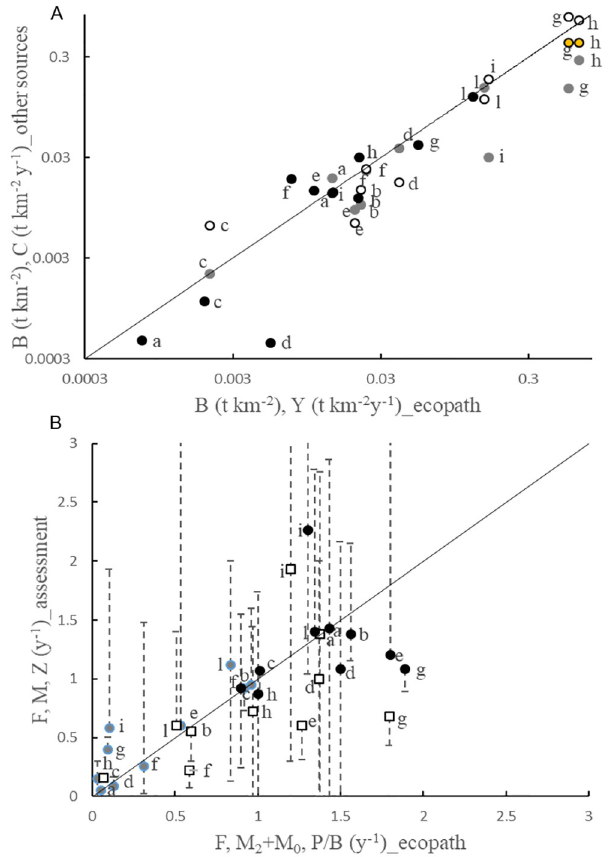
Fig 2. Comparison of variables and parameters for species with detailed stock assessments. (A) Comparison of biomass and catches used in the Ecopath model (x-axis) and other sources of information (y-axis). Biomass (t km -2 ): gray = Ecopath vs stock assessment, white = Ecopath vs MEDITS corrected for catchability, orange = Ecopath vs acoustic-survey only for ENG (g) and SAR (h). Catches (t km -2 y -1 ): black = Ecopath vs stock assessment. (B) Comparison of annual mortality rates (y -1 ) used in the Ecopath model and stock assessments. Whiskers indicate MAX and MIN used in stock assessments for different age classes corresponding to Ecopath stanzas. Gray dot = Fishing mortality (F), white square = natural mortality (M) or sum of predation and other mortality (M 2 +M 0 ), black dot = total mortality (P/B or Z). a = HAK2, b = HAK3, c = HAK4, d = MUL2, e = MUL3, f = PAG, g = ENG, h = SAR, i = ARF, l =